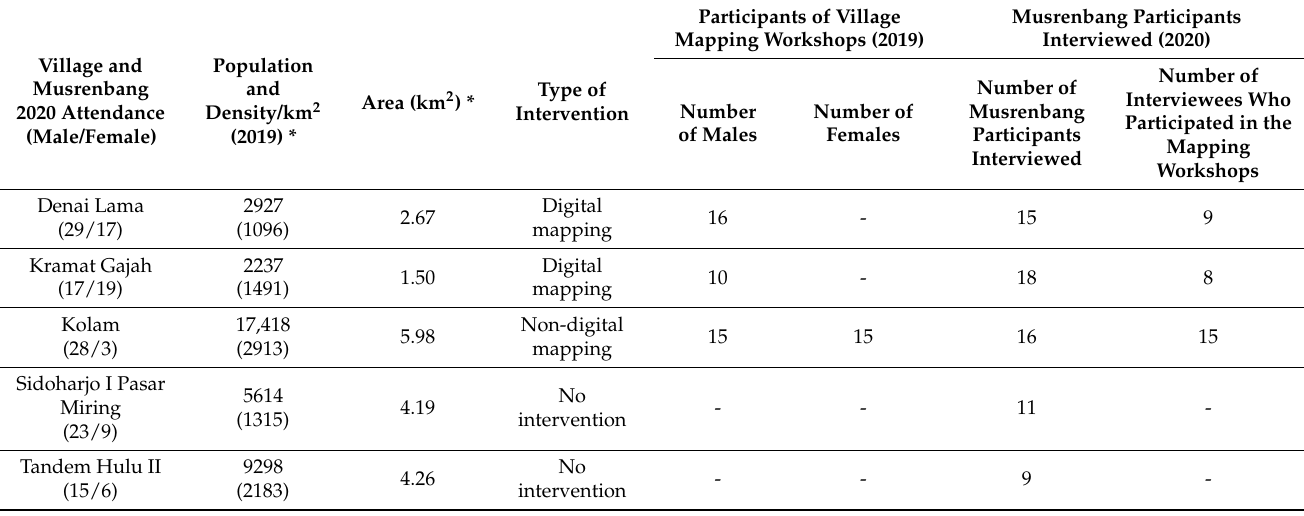
Table 1. Information about participatory mapping workshop participants, Musrenbang participants, and interviewees.